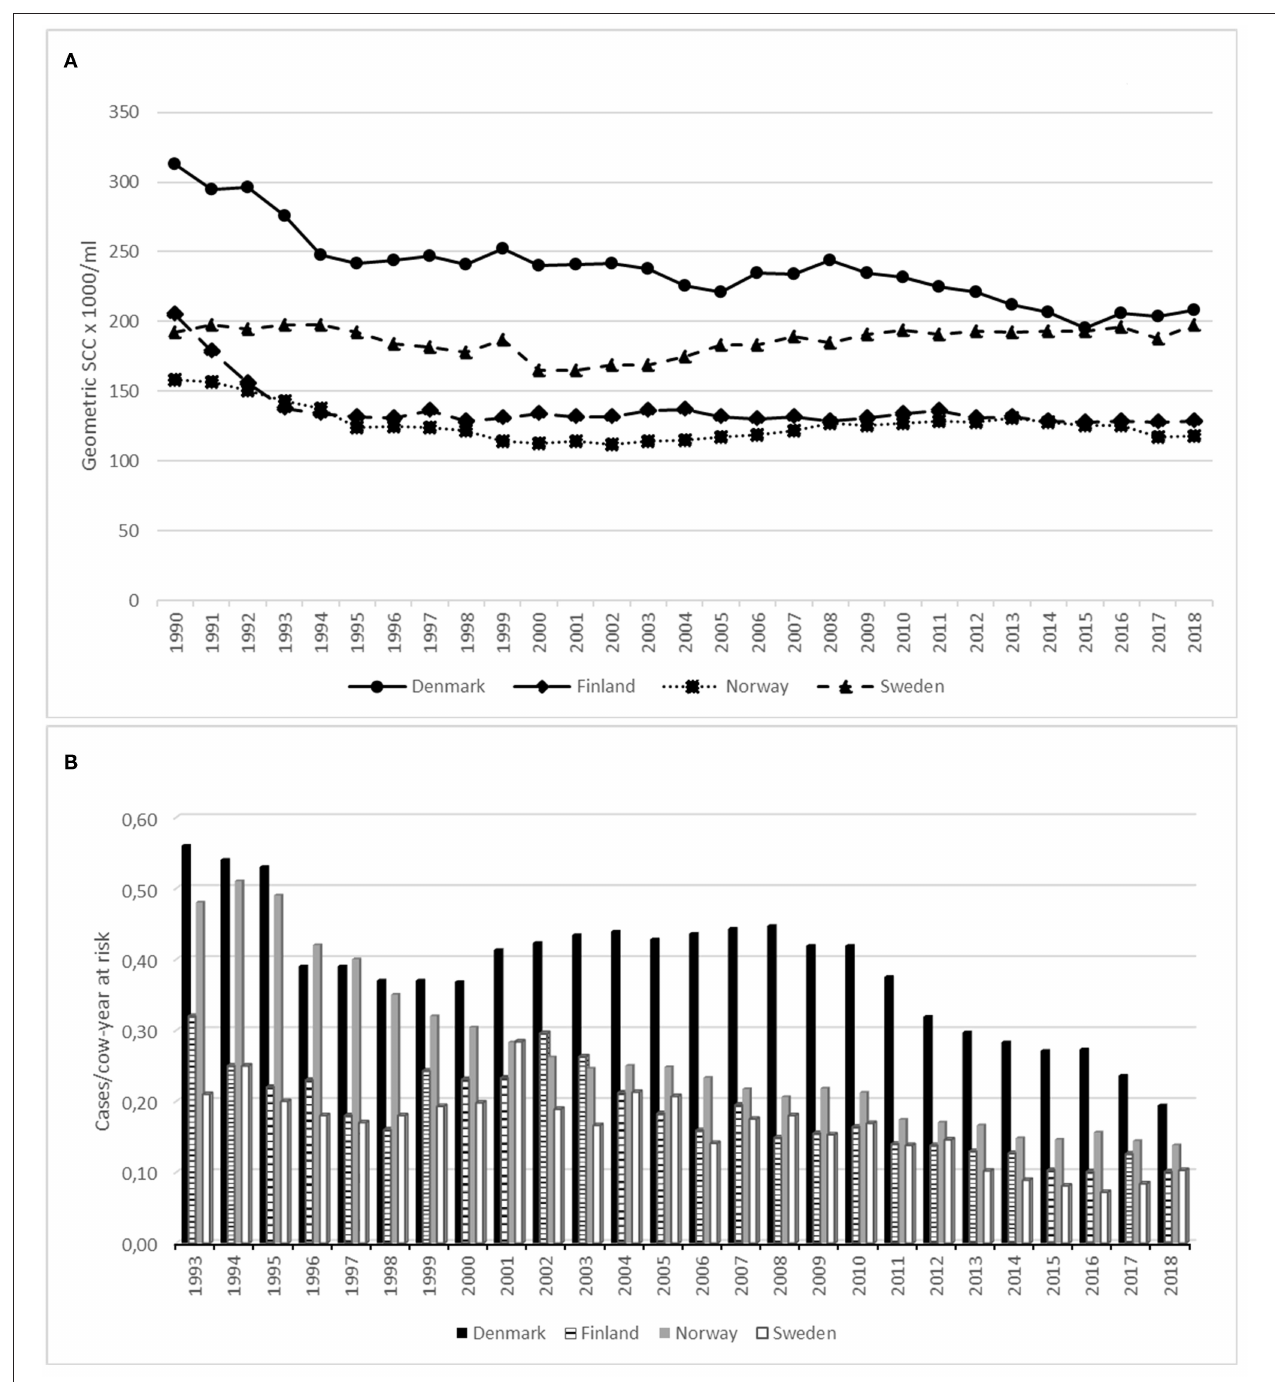
FIGURE 1 | Geometric mean of bulk tank milk somatic cell count (SCC) (cells × 1,000/mL) from 1990 to 2018 (A) and incidence rate of clinical mastitis* (cases/cow year at risk) from 1993 to 2018 (B) in four Nordic countries. *All treatments are administered or initiated by a